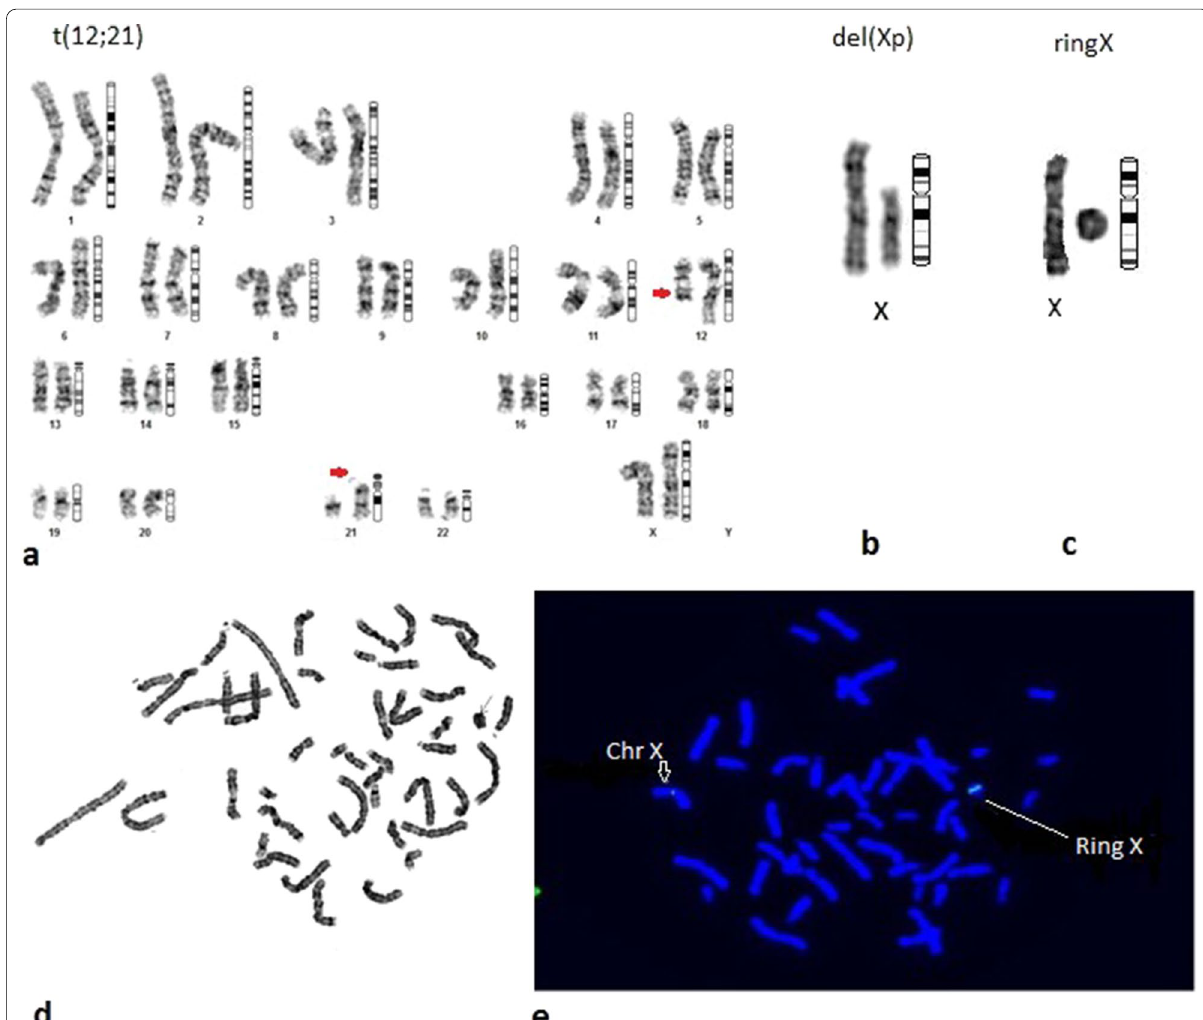
Fig. 1 Types of chromosomal abnormalities. a Karyotype of t (12;21), b partial karyotype of del (Xp), c Partial karyotype of ring (X), d metaphase showing ring X chromosome, e Fluorescence in situ hybridization (FISH) showing ring (marker) chromosome positive for centromeric X probe